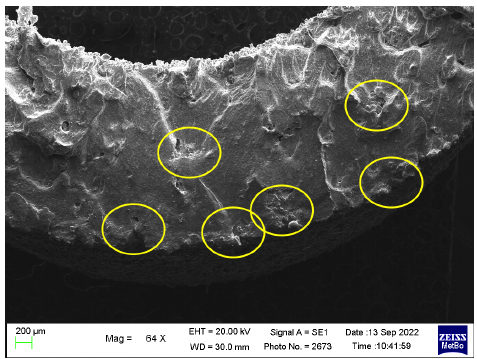
Figure 8. Multiple crack starters on T6-treated